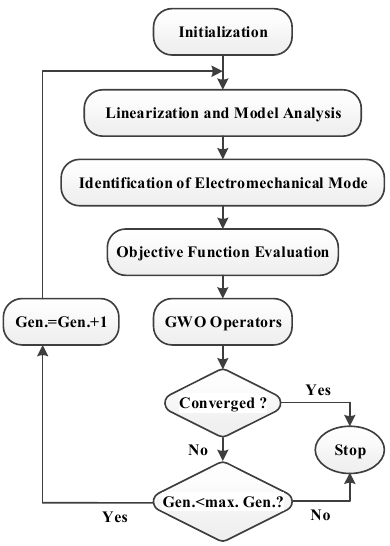
Figure 6. The flow chart of suggested GWO algorithm for tuning parameters of PSSs and PODs.